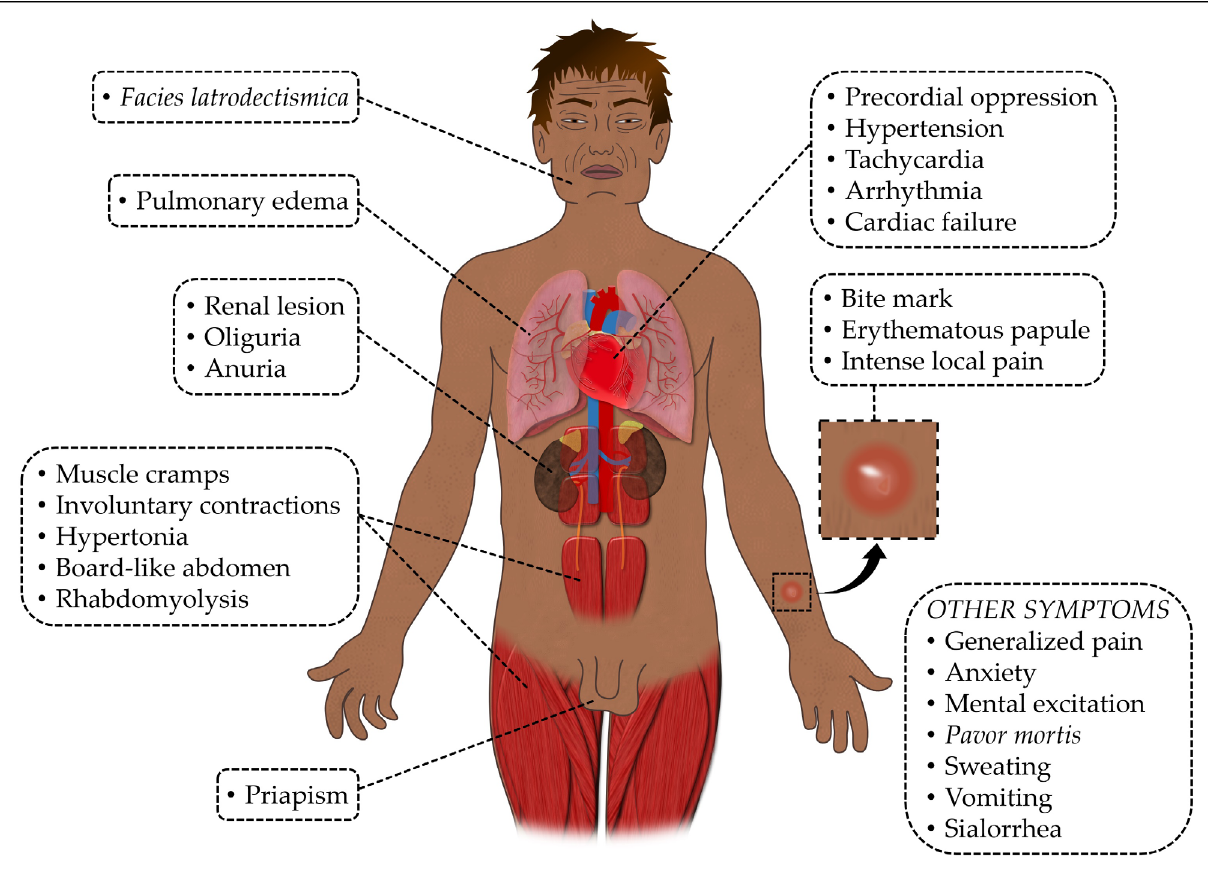
Figure 2. Local and systemic clinical manifestations of